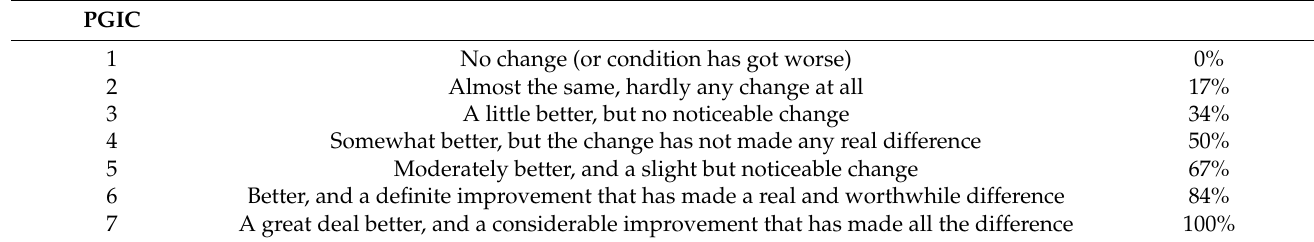
Table 1. Patient’s Global Impression of Change Scale (PGIC)